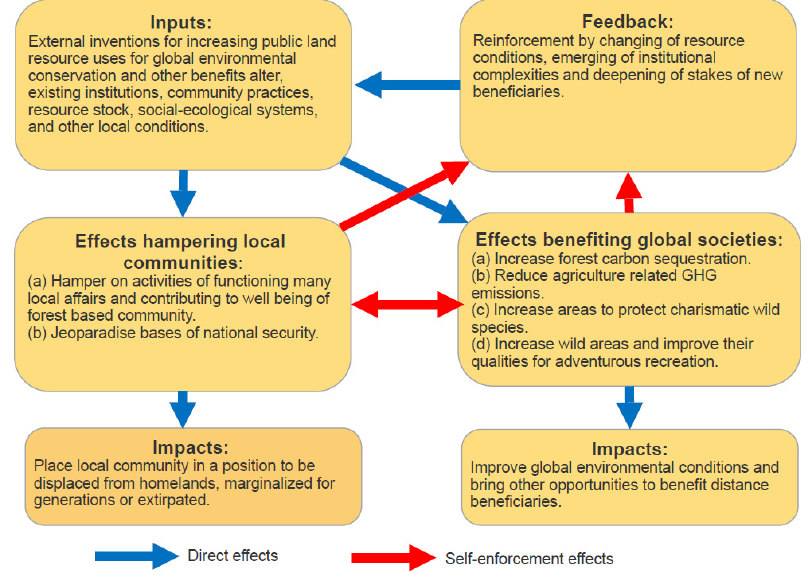
Figure 1. Phenomena and tradeoff outcomes resulted from external interventions in the management of local land resources for global benefits.